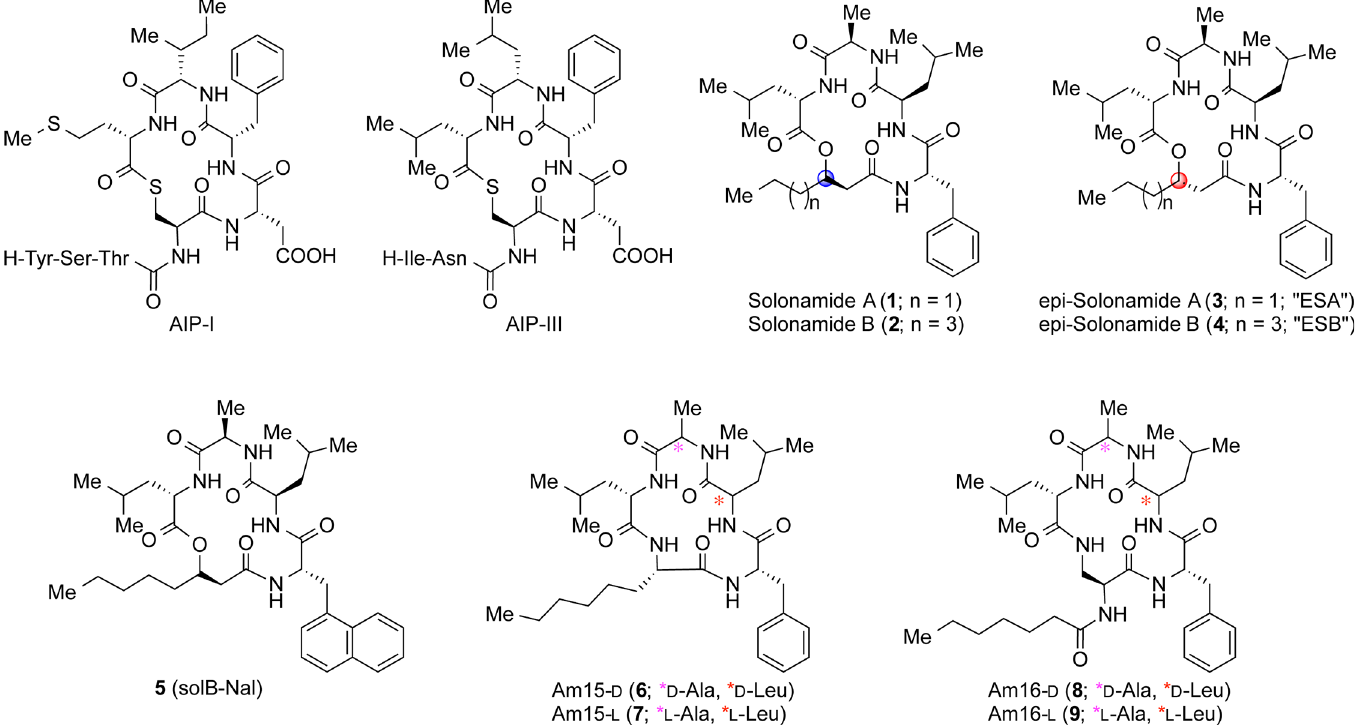
Fig 1. Compound and AIP Structures. Structures of autoinducing peptides (AIP-I and III) used in the study as well as tested depsipeptides and their modified lactam